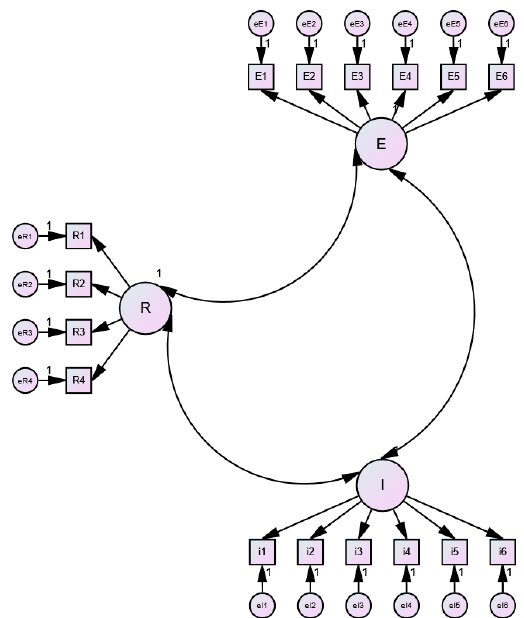
Figure 4. Correlation diagram of the confirmatory factor analysis. Items and dimensions are from the REI scale. n = 156 students from agrarian schools with